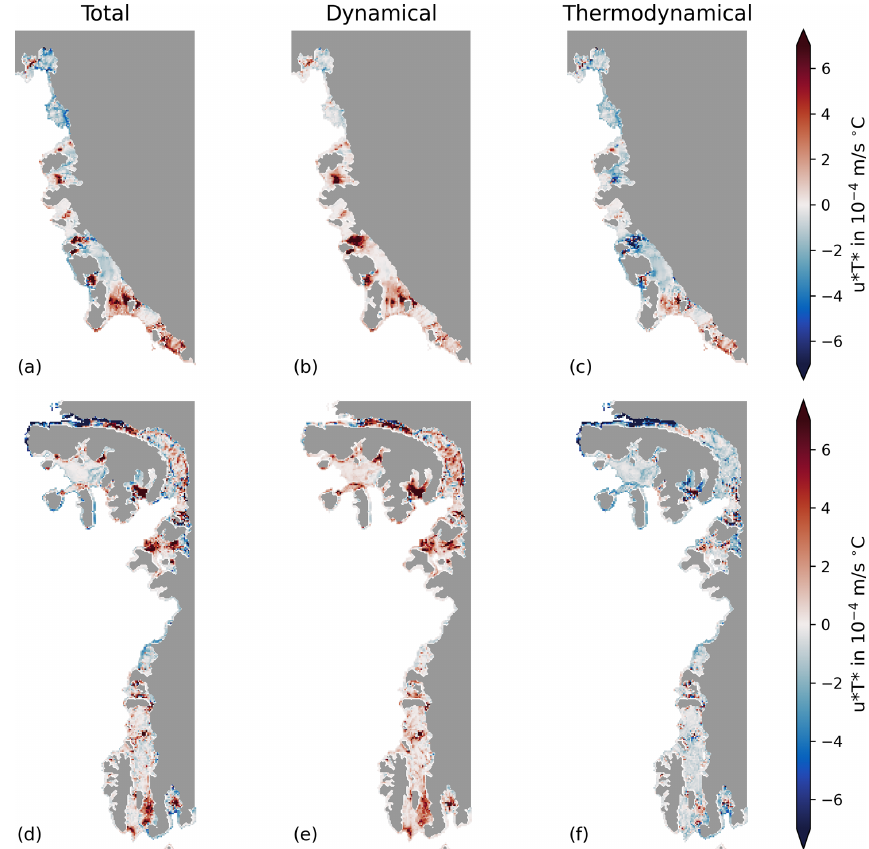
Figure 6. Dynamical–thermodynamical decomposition of tidal melting in warm regimes. Difference in melting when accounting for all components, only the dynamical component and only the thermodynamical component for the ice shelves of the Amundsen (a–c) and Bellingshausen seas ( d–f ; following Eq.